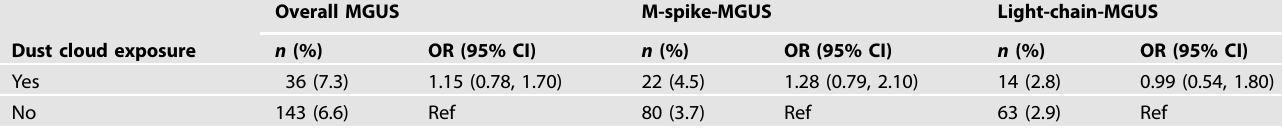
Table 3. Logistic regression evaluating World Trade Center dust cloud exposure.